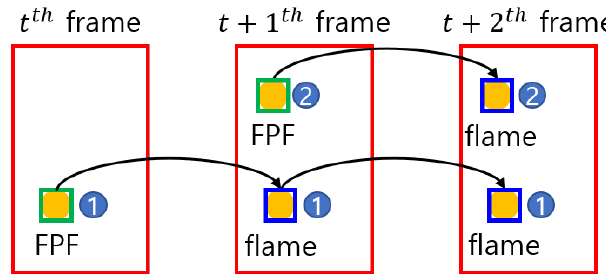
Figure 3. A toy example representing the difference between the FPF (first penetrating fragment) and the flame.